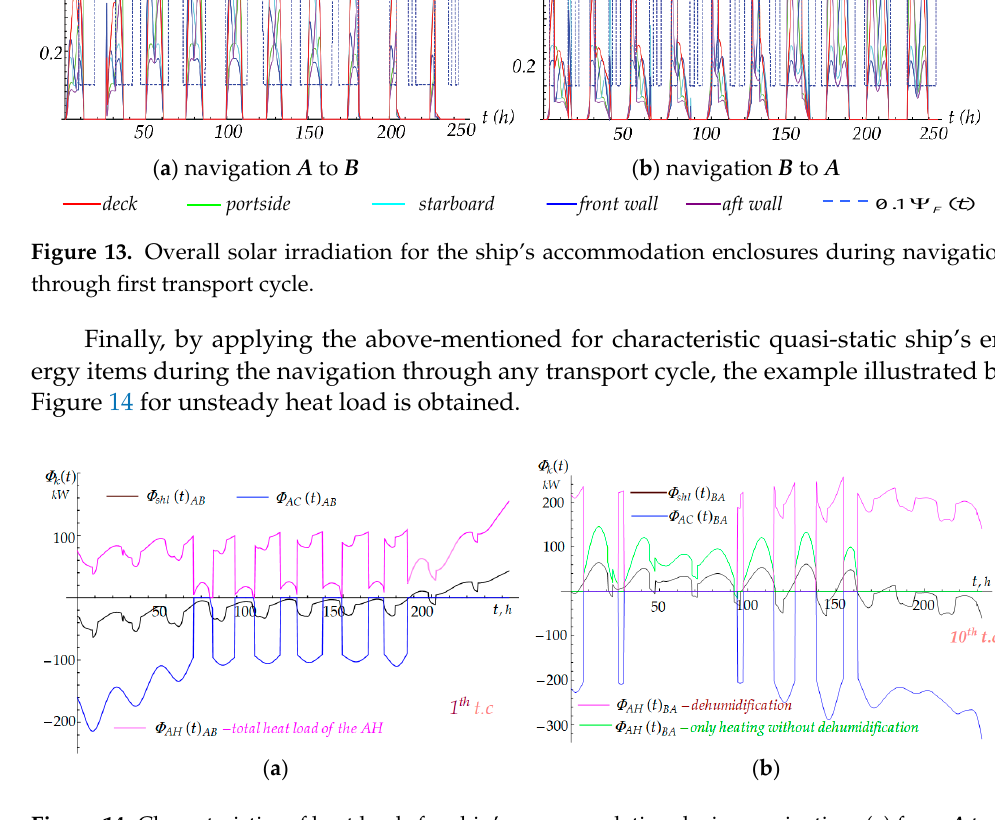
Figure 13. Overall solar irradiation for the ship’s accommodation enclosures during navigation through first transport cycle.